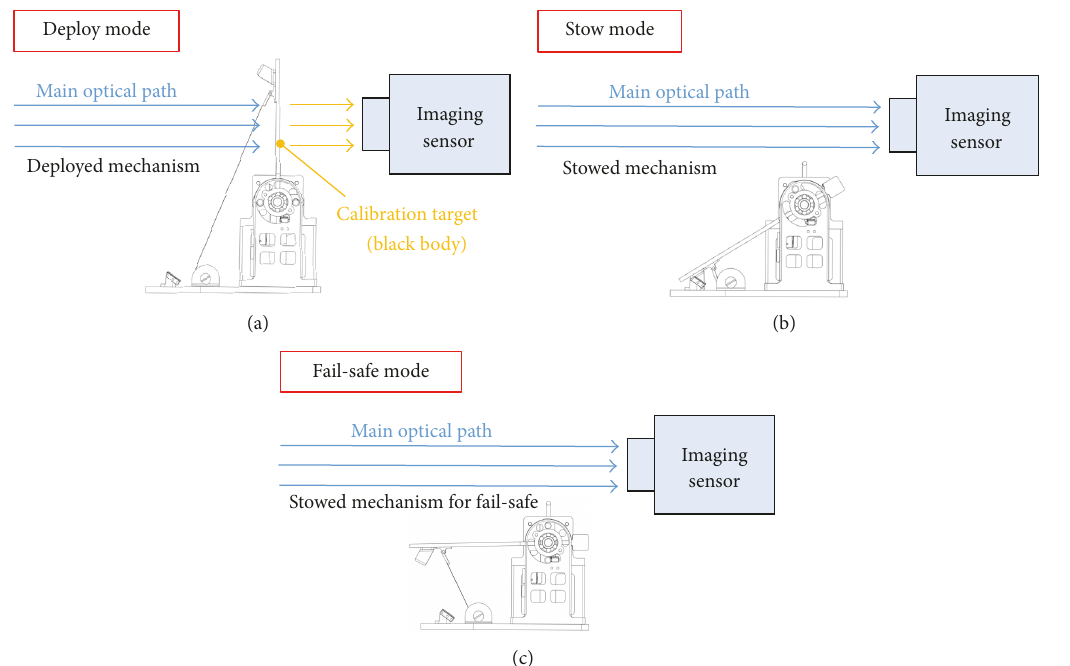
Figure 1: Operation concept of on-board calibration using the tilting calibration mechanism.